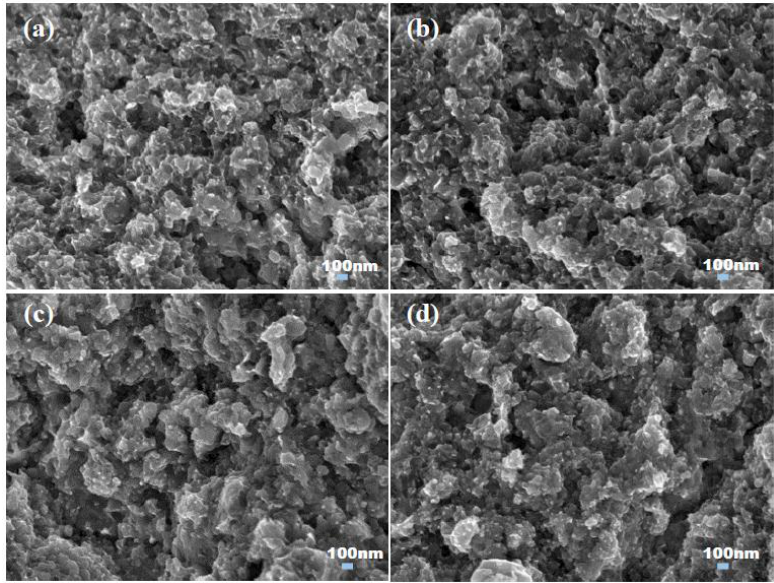
Figure 4. Fracture surfaces of the TiC–Cu nanocomposites spark plasma sintered at 800 °C: ( a ) 20 vol % TiC, nanocomposite A; ( b ) 20 vol % TiC, nanocomposite B; ( c ) 30 vol % TiC, nanocomposite A; and ( d ) 30 vol % TiC, nanocomposite B.